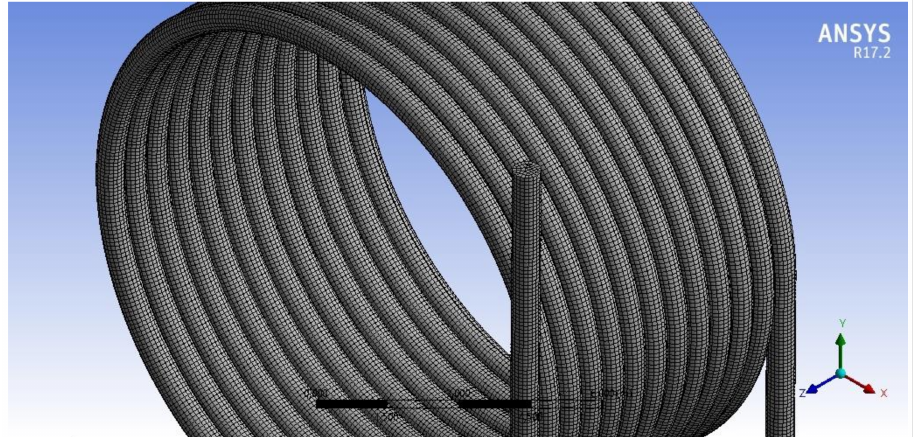
Figure 9. Mesh superimposed on a solid-state coil